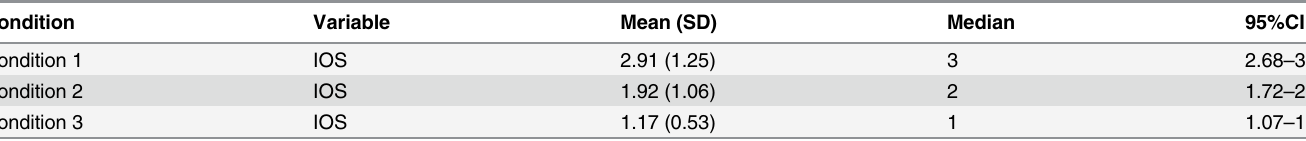
Table 7. Descriptive statistics for the